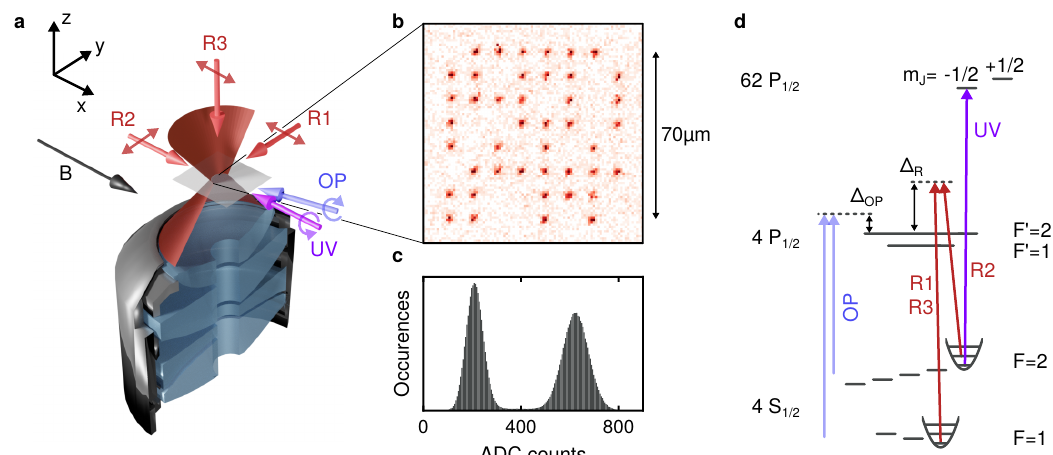
Figure 1: a. Sketch of the experimental setup with the high NA objective and the optical tweezers as well as the Raman beams (R1, R2, R3), the optical repumper (OP) and the UV beam for Rydberg excitation. Polarisations of the beams are indicated by arrows. b. A single fluorescence picture with 64 tweezers and c. Histogram of 20 · 10 3 experimental shots and 64 individual tweezers ( ≈ 1 million data points), demonstrating high fidelity readout. d. Relevant levels and transitions of 39 K for the Raman cooling and Rydberg excitation. The 4 P states (D2 line) used for MOT and 3 / 2 molasses cooling are not